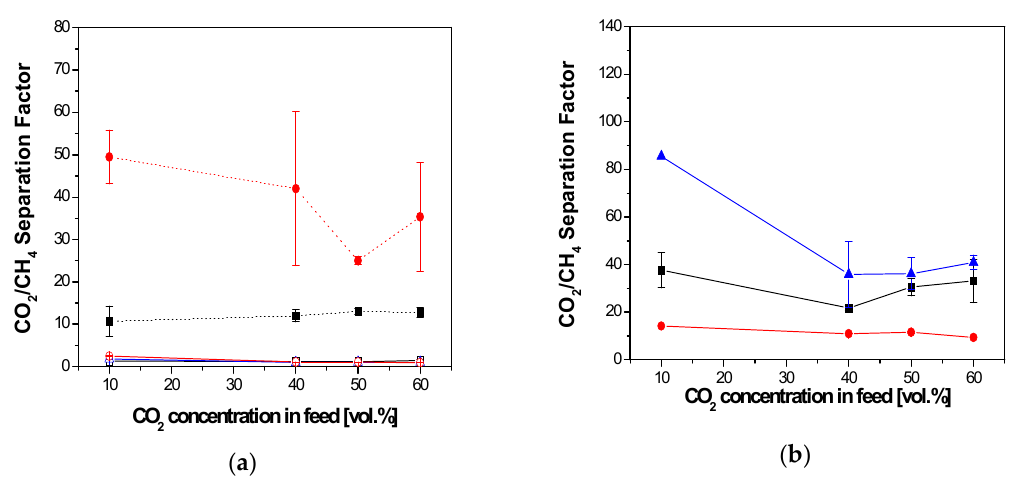
Figure 4. Influence of feed conditions on the CO 2 /CH 4 separation factor of the commercial hydrophobic PDMS membrane ( a ) and the hydrophilic IL–CS/PES ( b ), in the absence (squares) and presence of water vapor (blue) and toluene (red) impurities. Void symbols in Figure 4a correspond to the experimental values measured with the un-treated commercial PDMS membrane for comparison purposes. Lines are a guide to the eye.